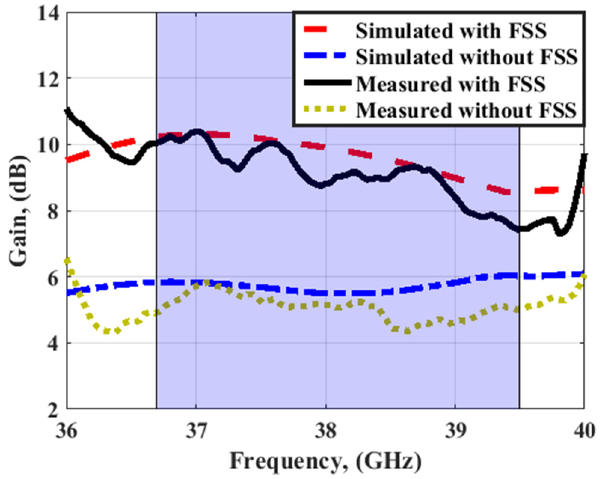
Figure 25. The simulated and measured peak gain outcomes of the MIMO antenna with/without FSS at port 1.